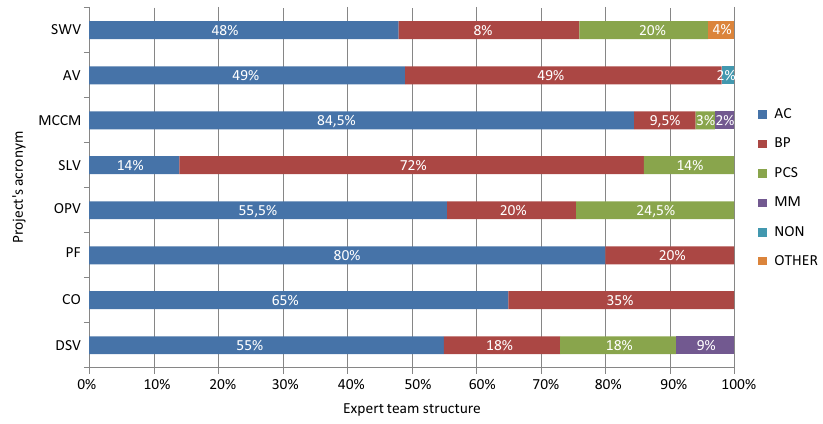
Fig. 2. Expert structure in chosen regional and trade foresight